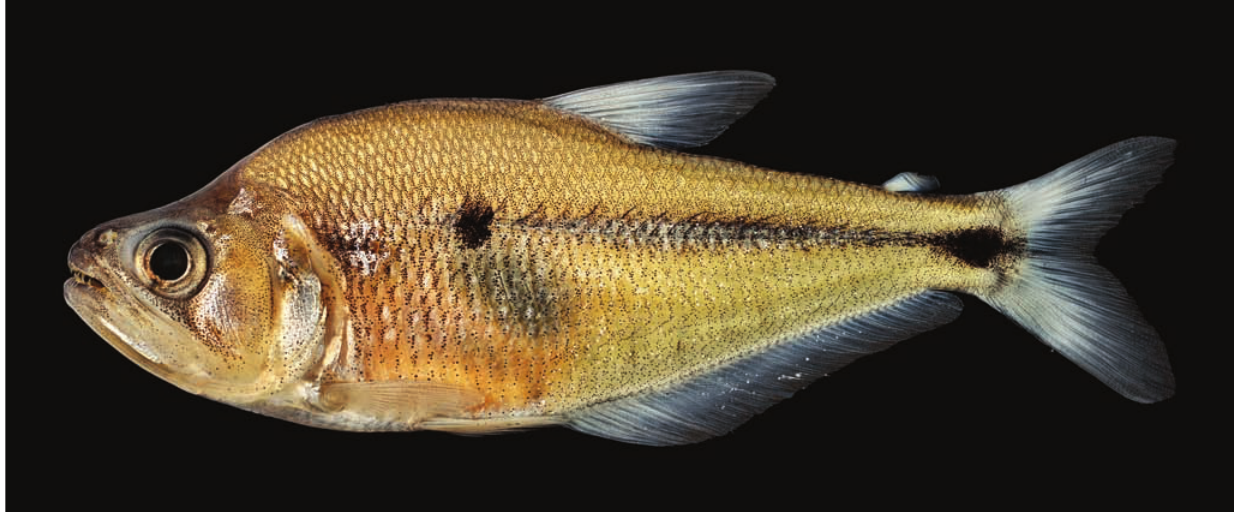
Fig. 26. Charax tectifer , MUSM 38670, male, 85 mm SL, Peru, Satipo, río Tambo, Quebrada